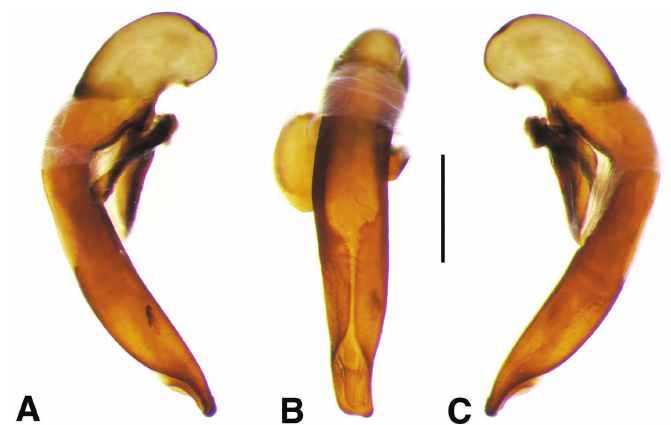
Figure 11 . Digital images of male genitalia of Neodiachipteryx cariniger (Putzey). A right lateral aspect B dorsal aspect C left lateral aspect. Scale bar 1 mm.